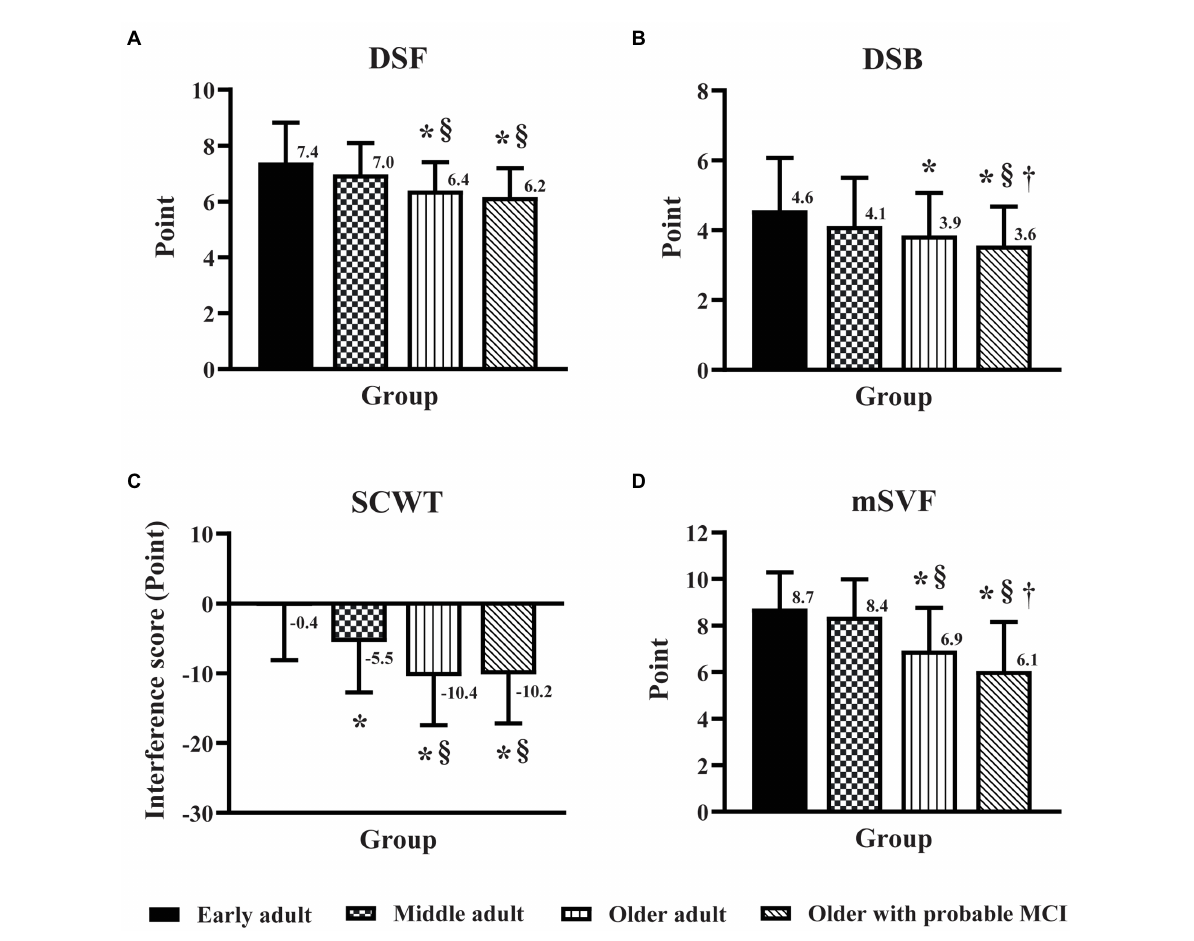
FIGURE 1 Effect of age and mild cognitive impairment on executive function domains. Executive function was assessed by the digit span forward task (A) , the digit span backward task (B) , the Stroop color-word test (C) , and the modified switching verbal fluency test (D) in early adult, middle